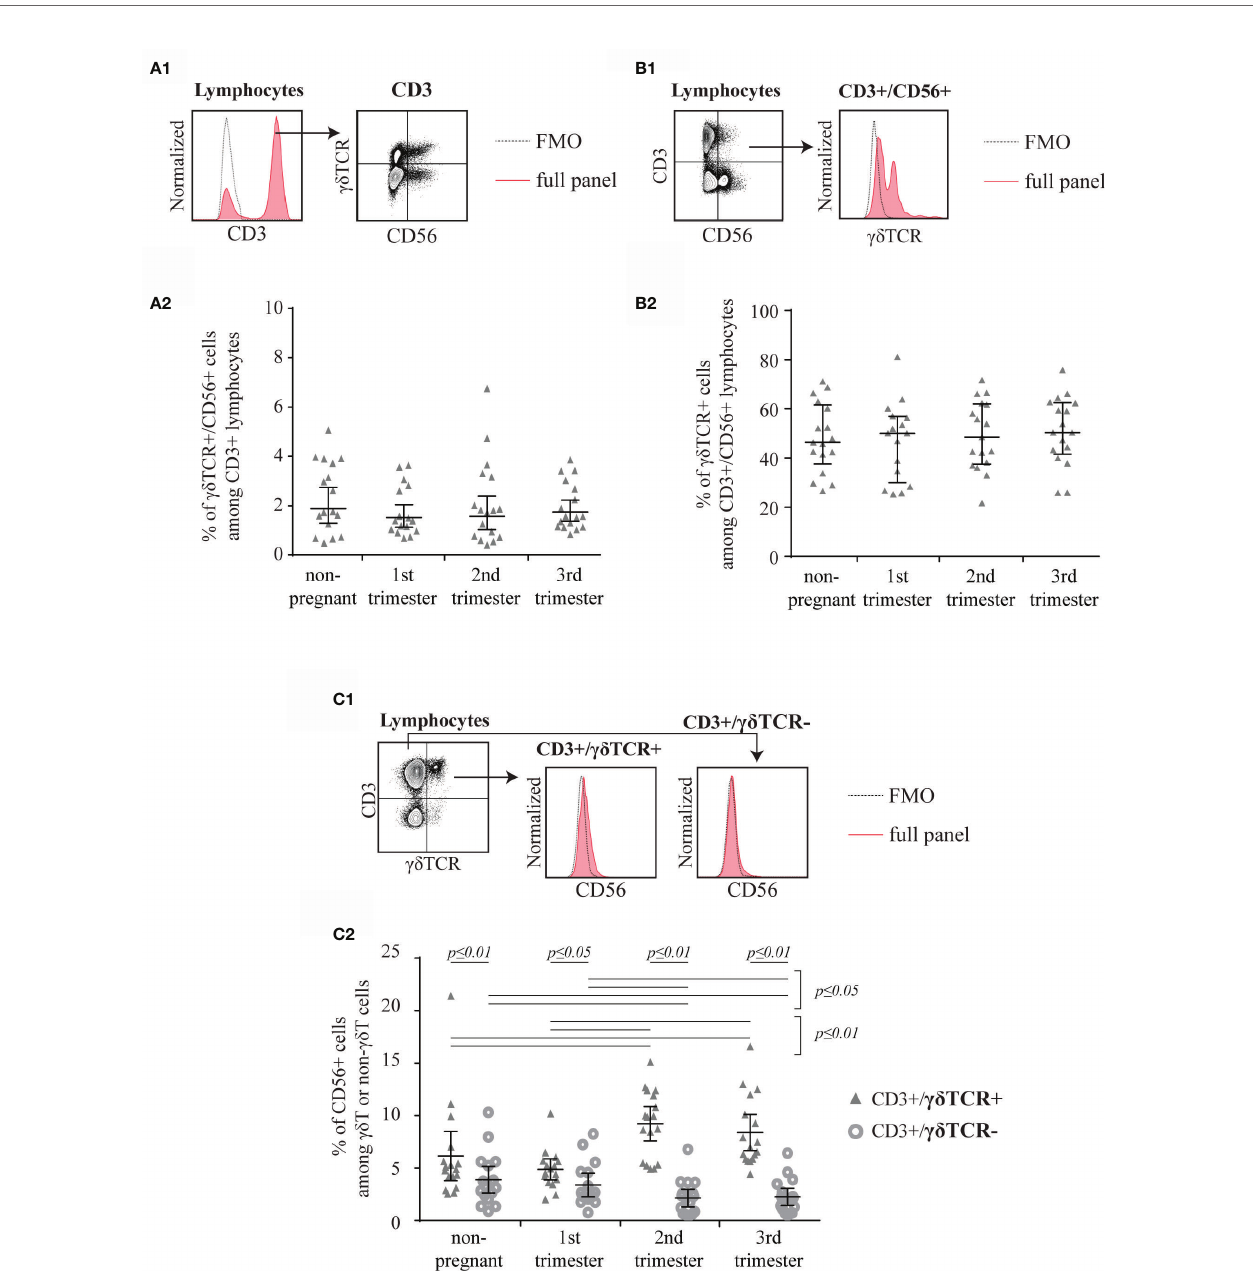
FIGURE 1 | Representative, shortened gating: First gated for CD3+ cells in a histogram (the fl uorescence-minus-one control (FMO) is depicted by the dotted line) then for CD56 and gd TCR (A1) . The mean percentage of CD56+/ gd TCR+ cells among CD3+ peripheral blood lymphocytes of non-pregnant (n = 17) and pregnant [1 st (n = 16), 2 nd (n = 17), and 3 rd (n = 17) trimester] women is shown as horizontal line with the 95% con fi dence interval represented by whiskers. The individual data points are shown as triangles. Statistical analysis with Kruskal-Wallis test showed no signi fi cant alterations between the different groups (A2) . Representative, shortened gating: First gated for CD3+/CD56+ cells demonstrated as dot plot then for gd TCR+ cells in a histogram. The FMO is depicted by the dotted line (B1) . Mean percentage of gd TCR+ cells among CD3+/CD56+ peripheral blood lymphocytes of non-pregnant (n = 17) and pregnant [1 st (n = 16), 2 nd (n = 17), and 3 rd (n = 17) trimester] women depicted as horizontal line with the 95% con fi dence interval represented by whiskers. The individual data points are shown as triangles. Statistical analysis with Kruskal-Wallis test showed no signi fi cant alterations between the different groups (B2) . Representative, shortened gating: First gated for CD3+/ gd TCR+ or CD3+/ gd TCR − cells demonstrated as dot plot then for CD56+ cells in a histogram. The FMO is depicted by the dotted line (C1) . Mean percentage of CD56+ cells among CD3+/ gd TCR+ and CD3+/ gd TCR − peripheral blood lymphocytes of non-pregnant (n = 17) and pregnant [1st (n = 16), 2nd (n = 17), and 3rd (n = 17) trimester] women depicted as horizontal line with the 95% con fi dence interval represented by whiskers. The individual data points are shown as triangles (CD3+/ gd TCR+) or circles (CD3+/ gd TCR − ). Statistical analysis was performed by using the Mann-Whitney test (non-pregnant vs 1st trimester vs 2nd trimester vs 3rd trimester) or the Wilcoxon test (CD3+/ gd TCR+ vs CD3+/ gd TCR − ). Signi fi cant differences are depicted by a horizontal line above the respective data sets (C2)